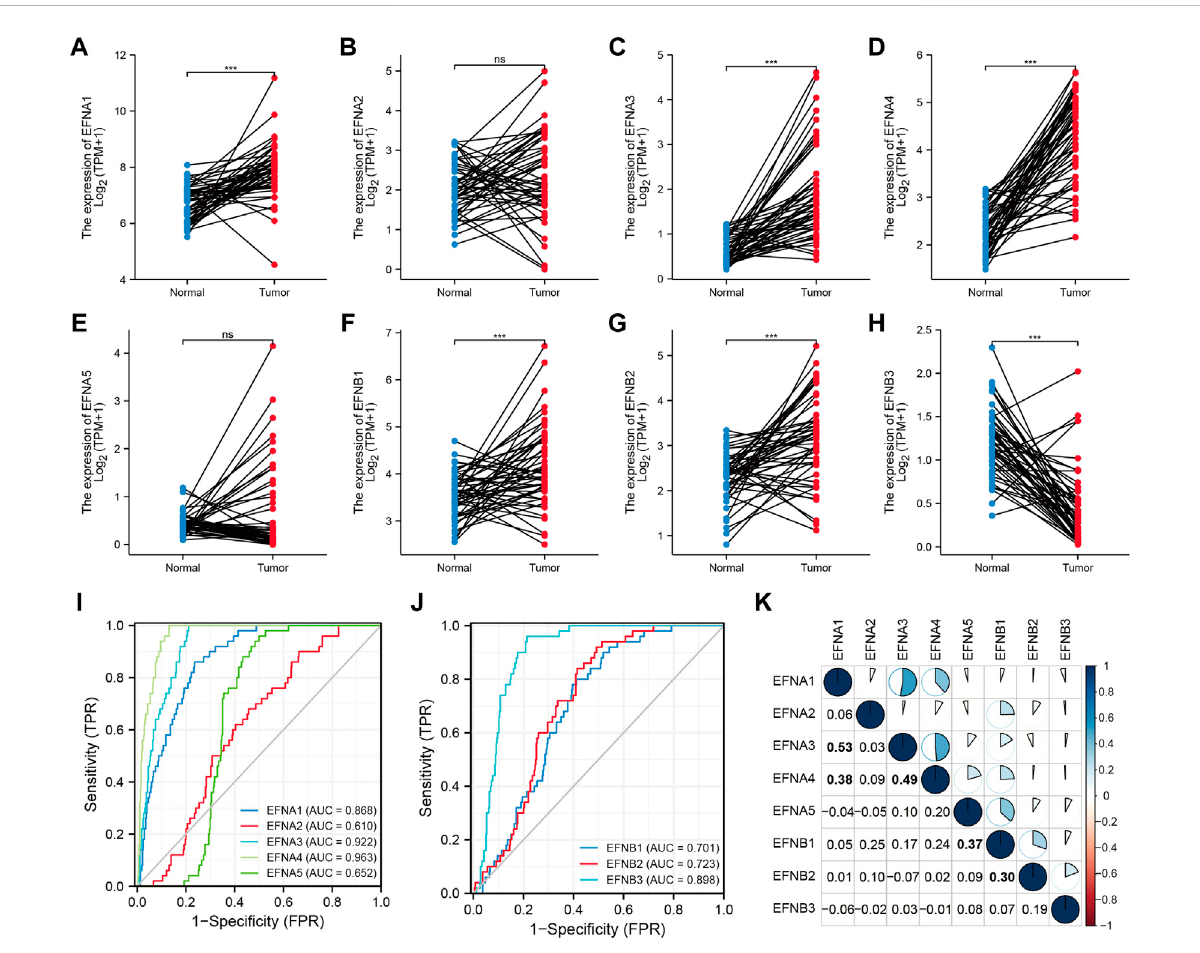
FIGURE 1 Theexpressionlevelsanddiagnosticsigni fi canceofephrinmembersinHCCtissuesbasedonTCGAdatabase. (A – H) Thedifferentialexpression of EFNs (EFNA1, EFNA2, EFNA3, EFNA4, EFNA5, EFNB1, EFNB2, EFNB3) in tumor tissues compared with paired normal tissues in HCC. ns: no signi fi cance; *** p < 0.001; (I,J) The diagnostic role of EFNs identi fi ed by receiver operating characteristic (ROC) curves. (K) Correlation analysis of each EFN member based on Pearson ’ s correlation analysis. The bold values represent signi fi cant correlations between the EFN